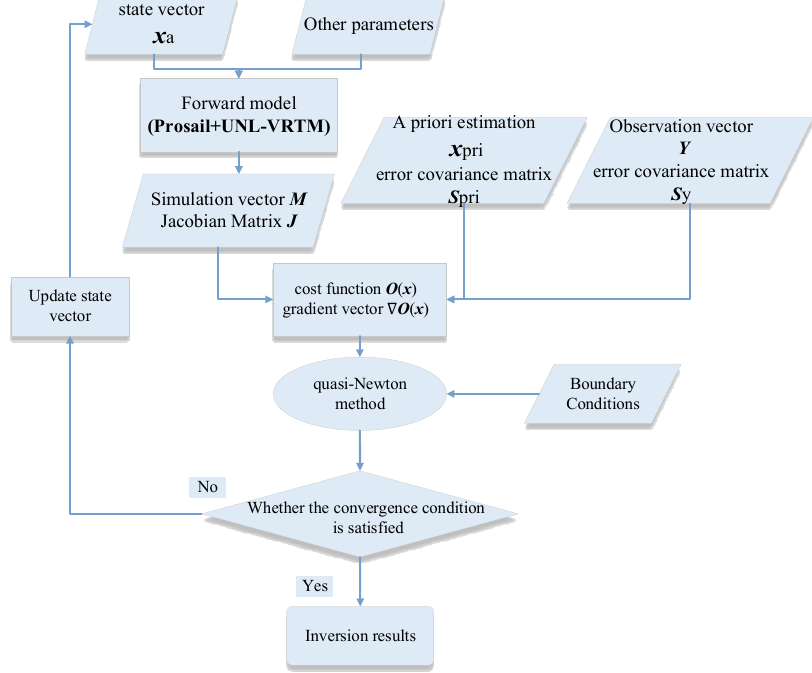
Figure 4. The optimization inversion flow chart based on